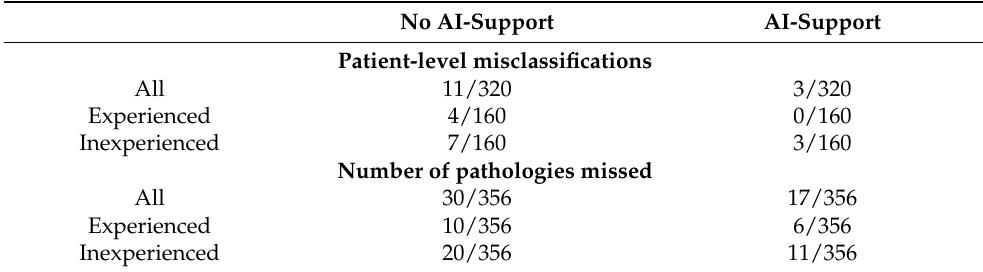
Table 1. Classification completeness for experienced and inexperienced readers with/without